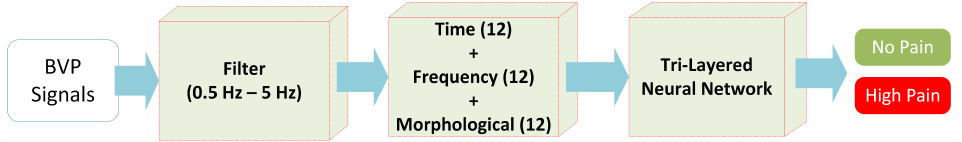
Figure 7. The proposed methodology for experiment 1 (no pain vs. high